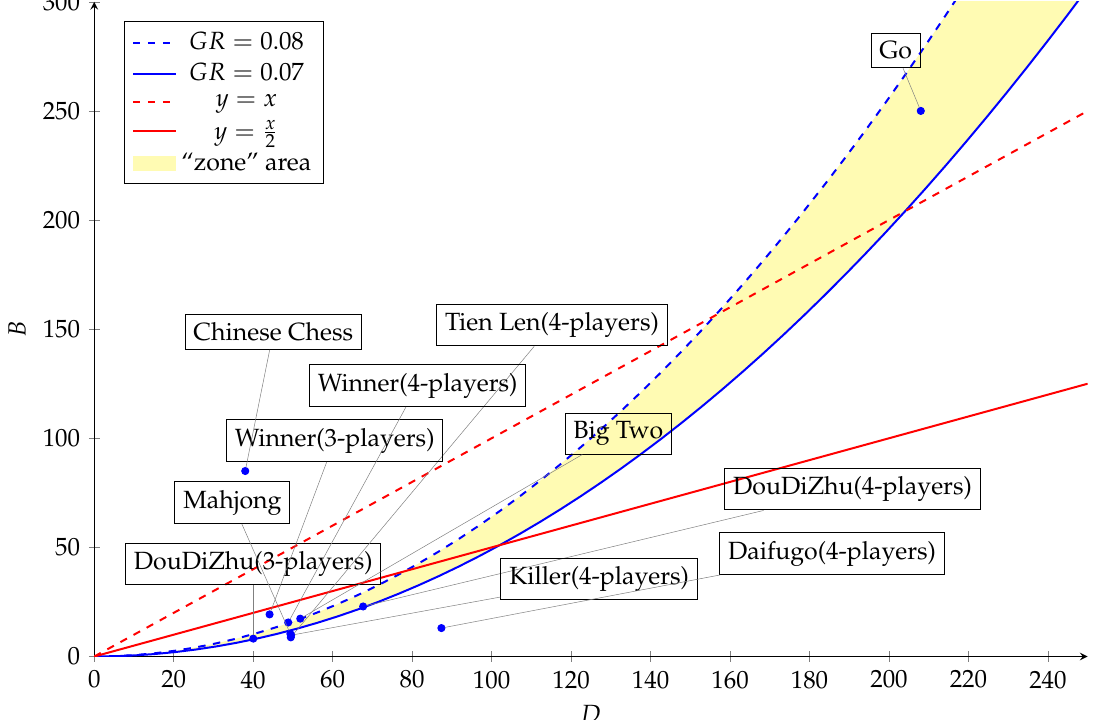
Figure 5. The depiction of game refinement values of the well-refined games mentioned in the